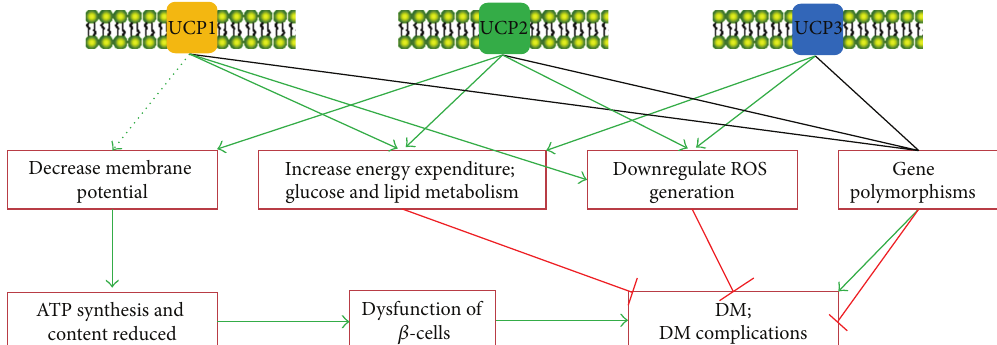
Figure 3: The role of UCPs on the development of DM and/or complications. UCPs may affect the development of DM through 4 aspects: decrease mitochondrial membrane potential, increase energy expenditure especially through glucose and lipid metabolisms, downregulate ROS generation, and gene polymorphisms. The green arrows represent pathways activation, the dotted green arrow means that this pathway needs to be further proved, and the red inhibition arrows represent the inhibition